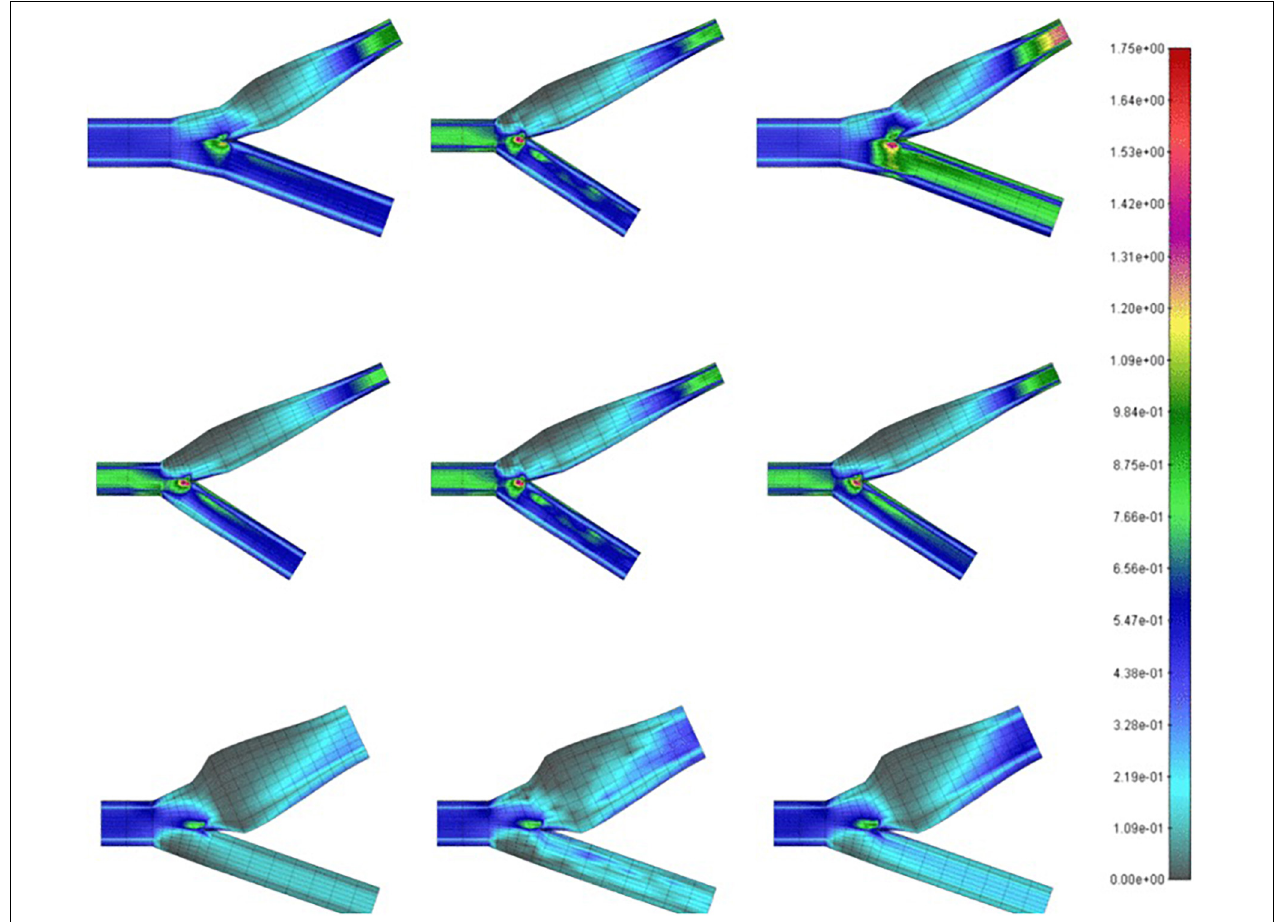
FIGURE 3 | Wall shear stress (in Pa) on carotid bifurcations of differing geometries obtained by CFD (left), MPL (middle), k-NN (right) algorithms (Milos et al.,